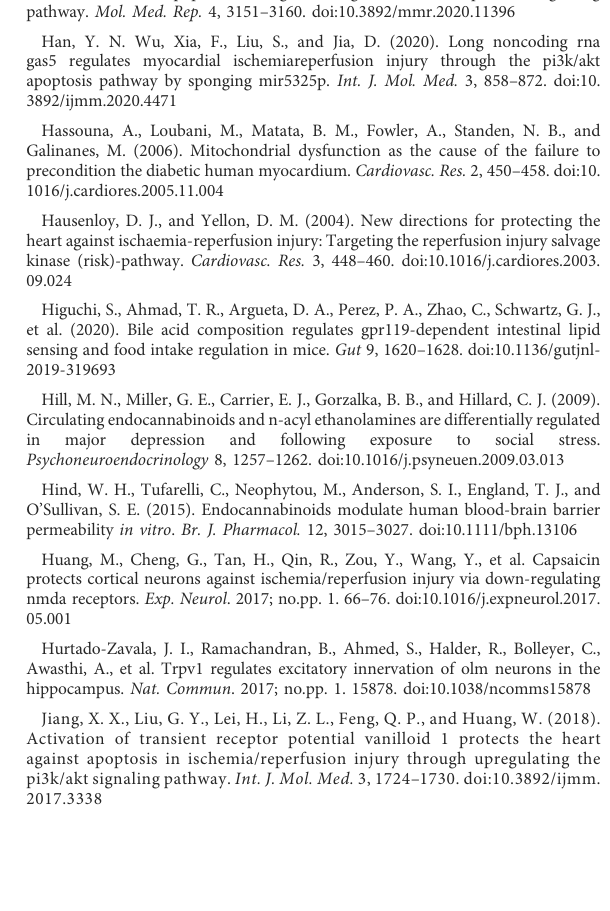
(A) Anatomical sketch of coronary artery ligation in rats. The black line represents the location of coronary artery ligation. AA, aortic arch; LCA, left coronary artery. (B) Schematic diagram of experimental group and administrationschemeinrats.I,ischemia;R,reperfusion. (C,D) Schematic diagram of H9C2 cell administration scheme. OGD, oxygen-glucose deprivation; R, reperfusion. SUPPLEMENTARY FIGURE S2 Establishmentofaratmodelofdiabeticmyocardialischemia-reperfusion injury. Rats were fed with high-fat diet for 8 weeks and received STZ for 72 h. (A) Weight of rats in DM group and NOR group ( n = 12). (B) Comparison of fasting blood glucose level between DM group and NOR group ( n = 12). (C) Glycosylated hemoglobin of rats in DM group compared with NOR group ( n = 12). (D) ST segment changes of electrocardiogram before ischemia, after ischemia, and after reperfusion in I/R group. Data were expressed as mean ± SEM, *** P < 0.001 vs. NOR group. SUPPLEMENTARY FIGURE S3 TheWBresults of TRPV1, P85andp-Akt protein levels in H9C2 cellsinduced byhighglucoseandOGD/RandpretreatedwithOEA. (A-B) Comparedwith the control group, the expression levels of TRPV1, P85, and p-Akt in HG group and HG + OGD group was signi fi cantly decreased. Data were expressed as mean ± SEM, ▲ P < 0.01, ▲▲ P < 0.001 vs. control